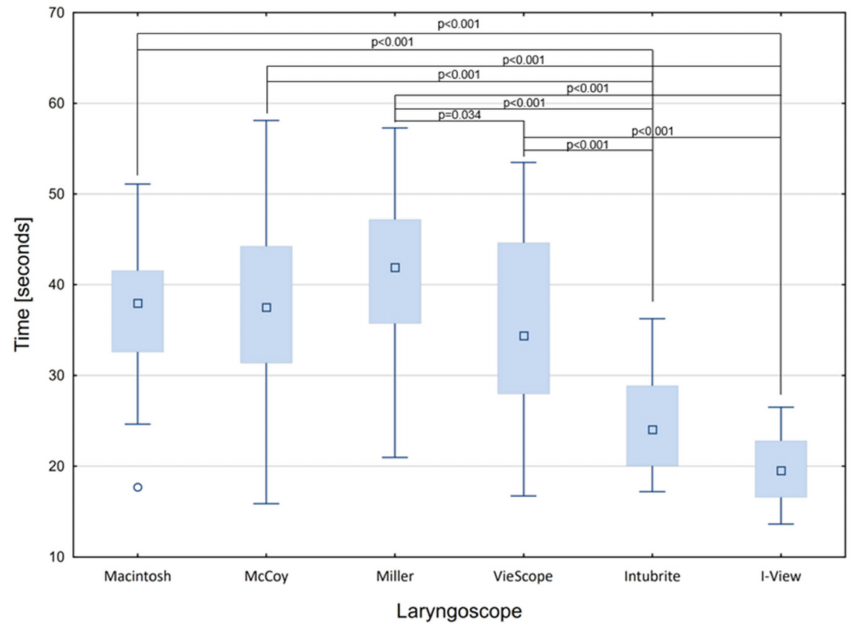
Figure 3. The mean time of intubation in different intubation approaches (Kruskal–Wallis test: p < 0.001, presented p are taken from the Dunn’s